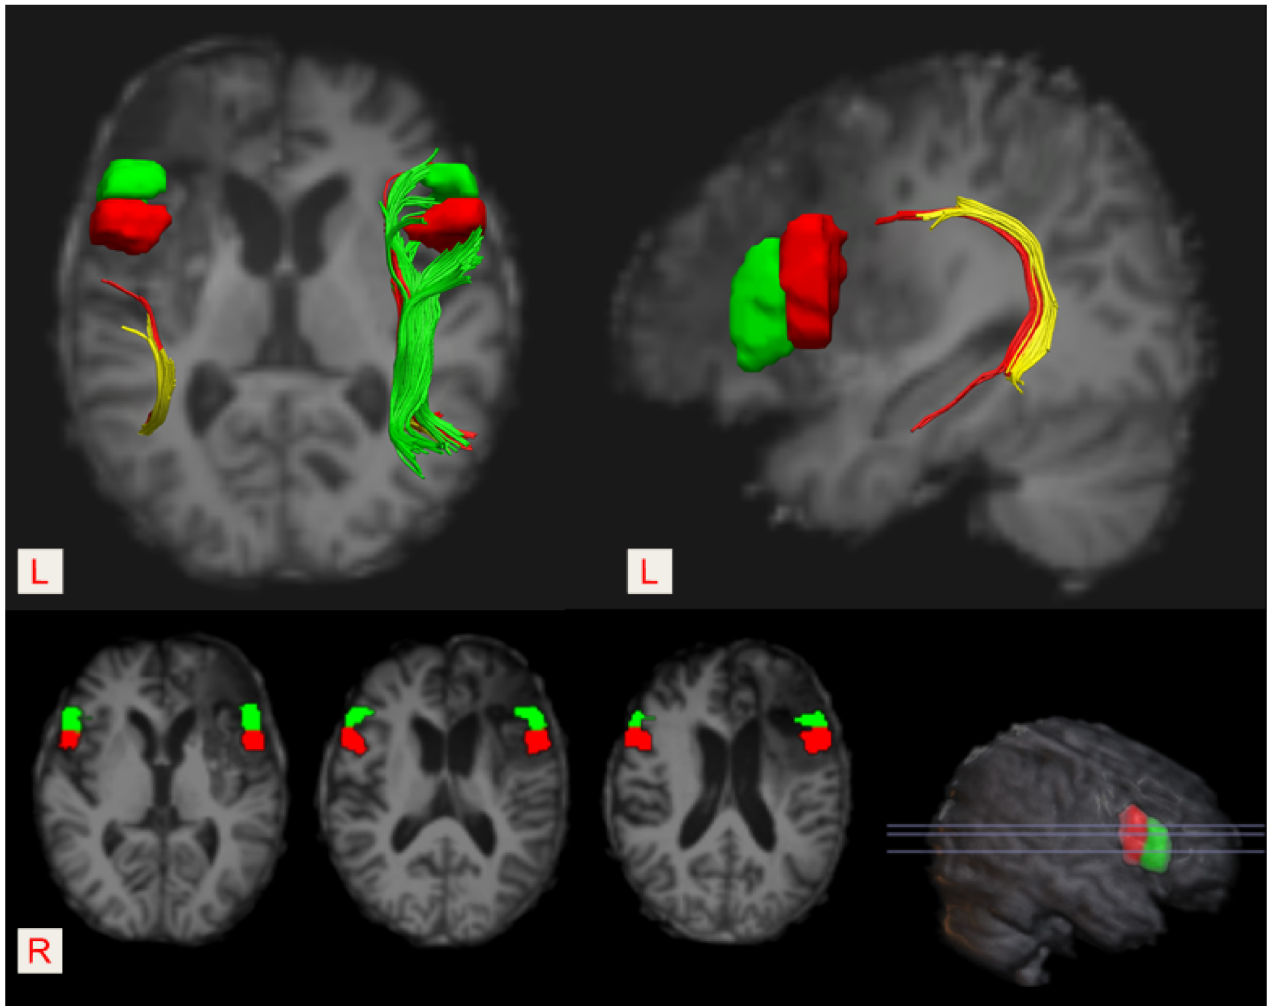
Figure 3. The location of the Broca’s area (pars opercularis and/or pars triangularis of the left inferior frontal gyrus) and its right homologous region. Pars opercularis—the red block, and pars triangularis—the green block. The left infarct lesion destroyed both pars opercularis and pars triangularis of the left inferior frontal gyrus.